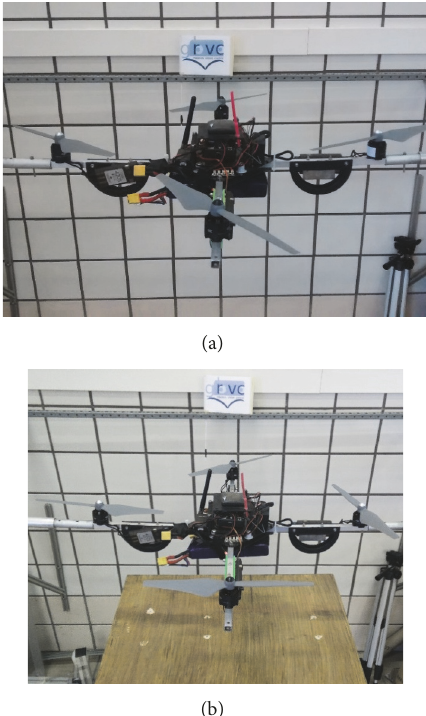
Figure 25: Experimental tests with multirotors in the test bench: (a) the PQUAD and (b) the PQUAD with a ground